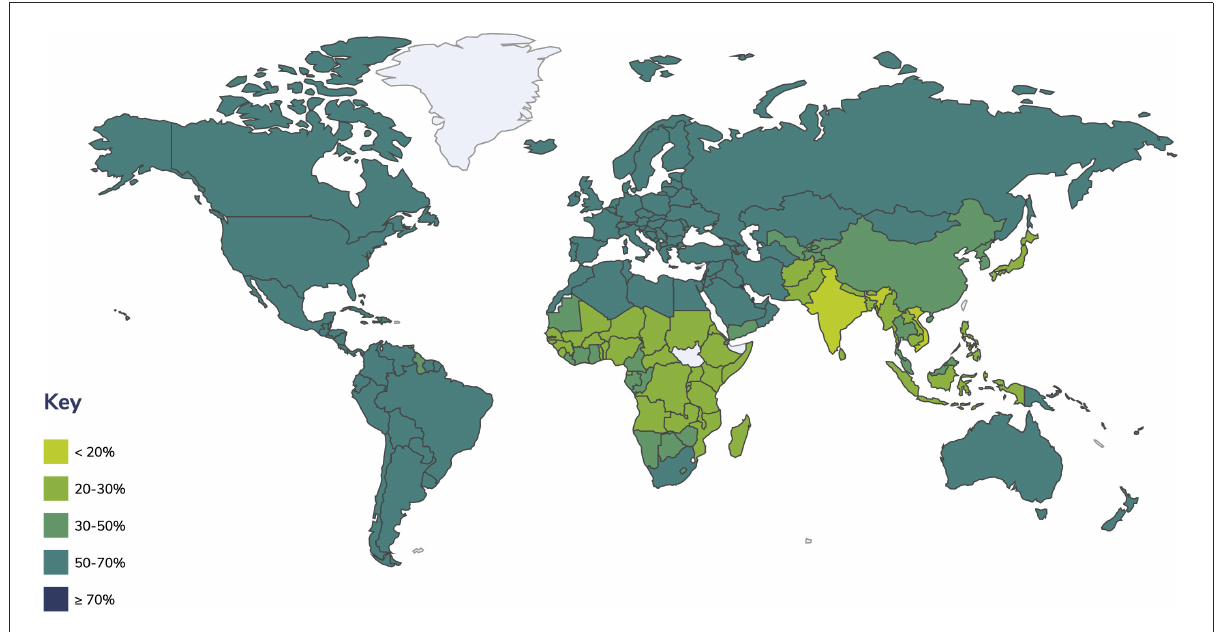
FIGURE1 Prevalence of overweight and obesity in adults. Estimates include adults with a BMI ≥ 25 kg/m 2 (WHO,